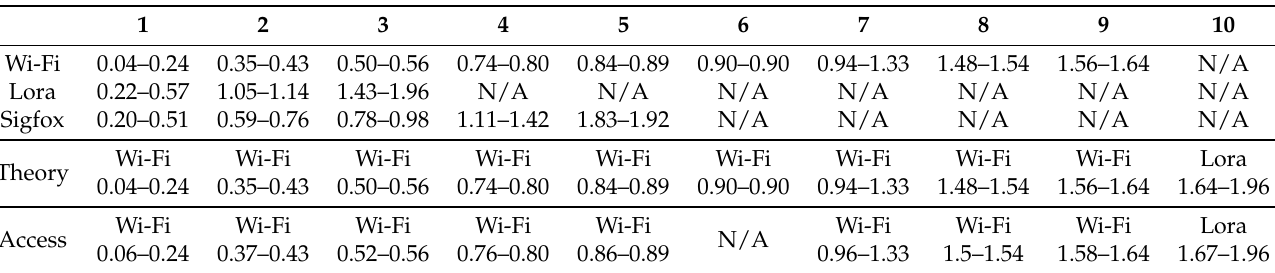
Figure 7. Communication performance with single UAV operation. Table 4. Probability of false alarm with its threshold value over